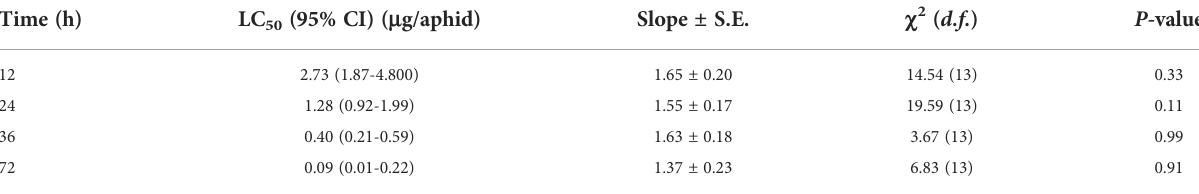
TABLE 2 The contact toxicity of PSO (pomelo seed oil) against Aphis craccivora. Time (h) LC 50 (95% CI) ( m g/aphid) Slope ± S.E.